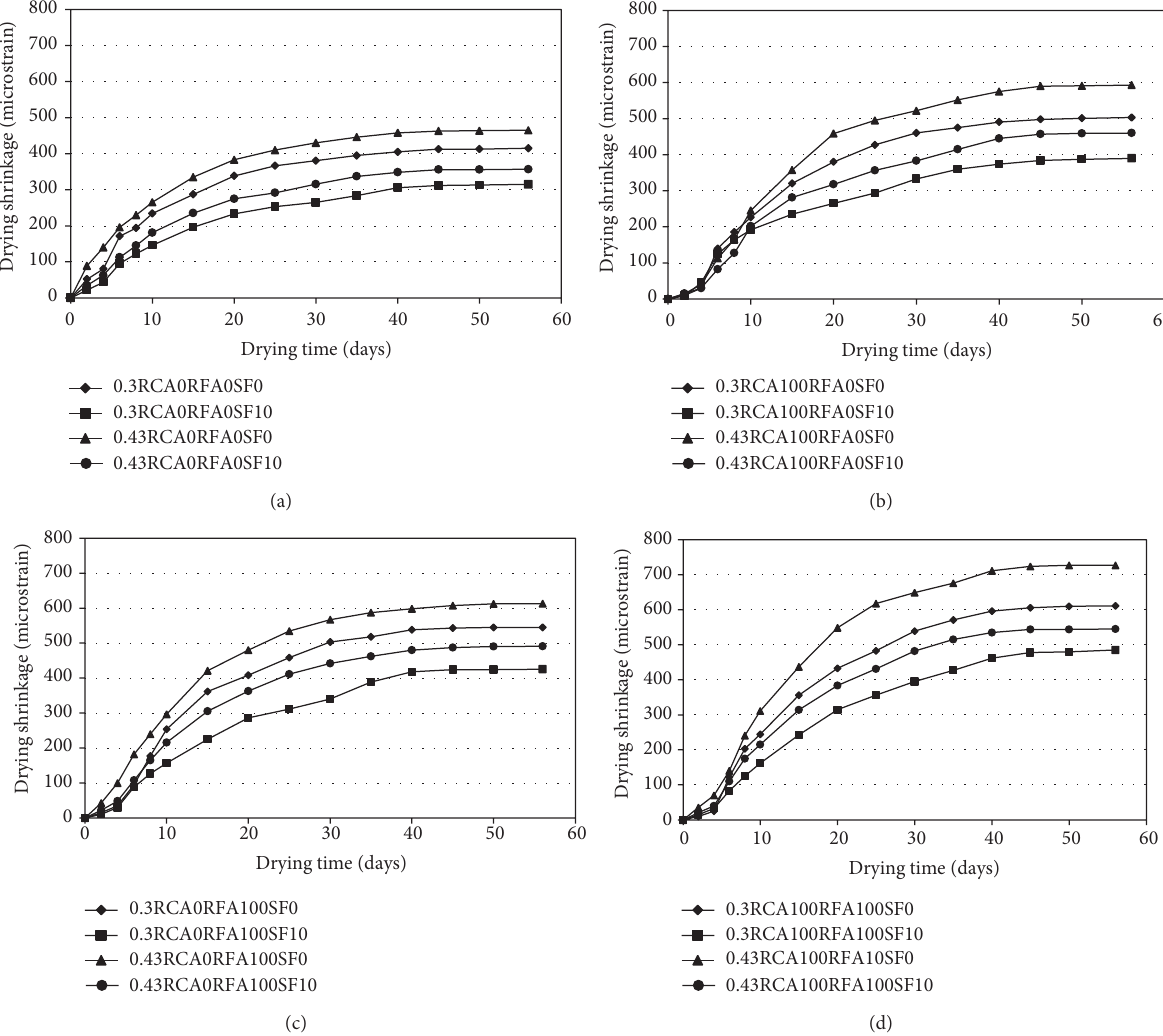
Figure 12: Drying shrinkage for SCCs according to type of aggregate: (a) NAs (Series I), (b) RCAs (Series II), (c) RFAs (Series III), and (d) RAs (Series